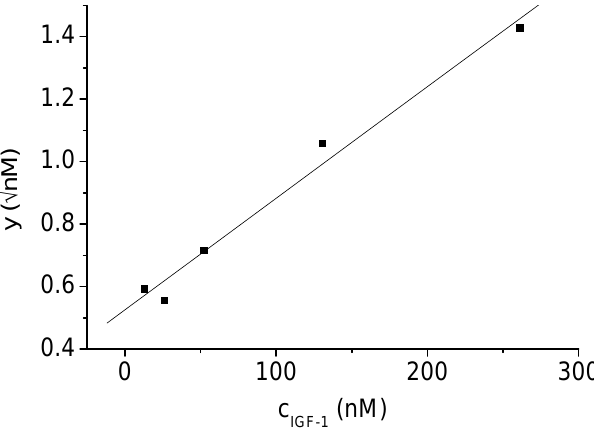
Figure 5. Scaled plot for the interaction between IGF-1 and the antibody